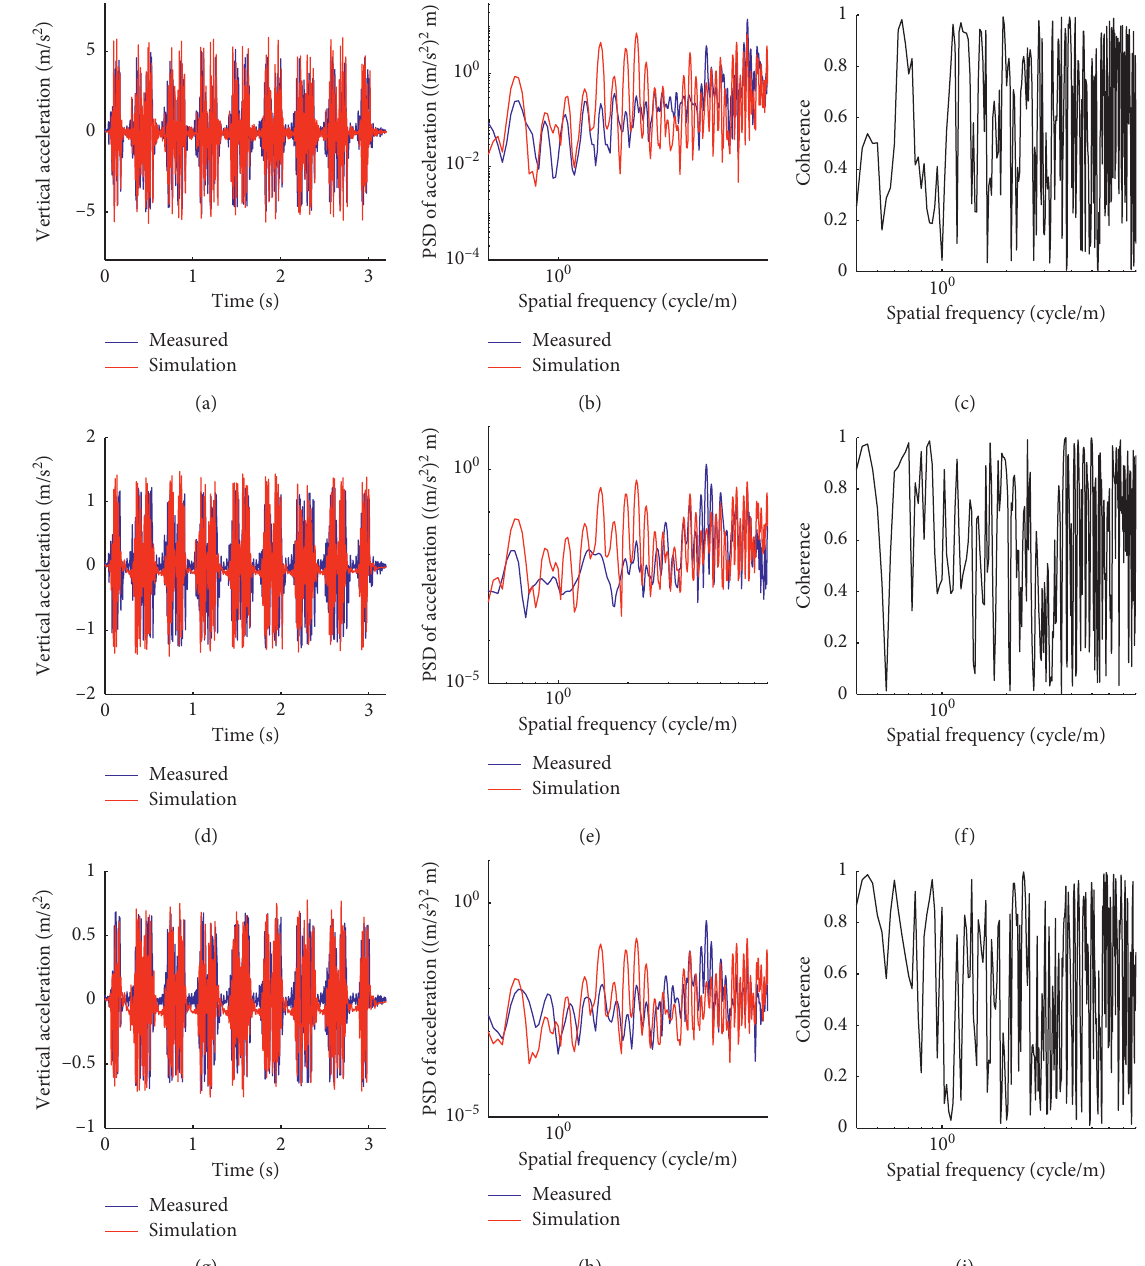
Figure 6: The simulated and measured acceleration (a, d, and g), the PSD content (b, e, and h), and corresponding coherence (c, f, and i) on the slab layer, on the base layer, and on the roadbed layer,